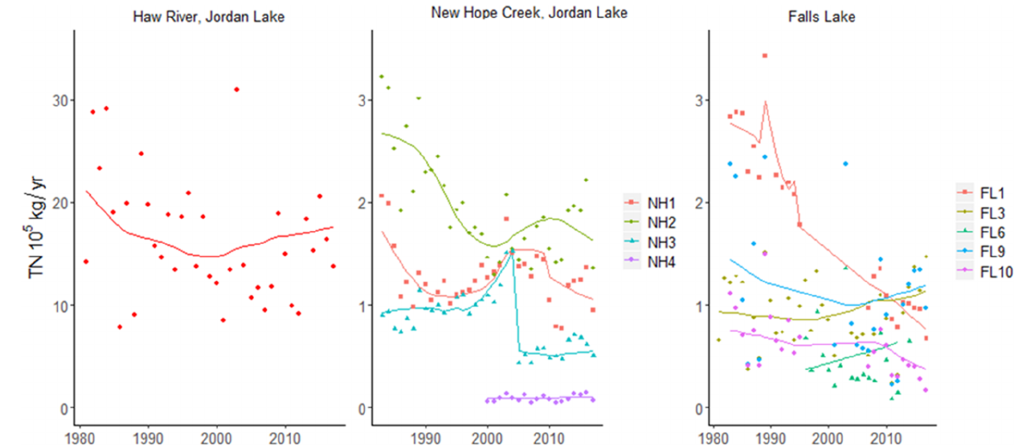
Figure 3. Weighted-regression on time, discharge, and season (WRTDS) annual nutrient loading estimates (points) and flow-normalized estimates (lines) for TN in the Haw River (HR) and New Hope Creek (NH) basins of Jordan Lake (JL) and Falls Lake (FL). For clarity, results are only shown for the most downstream load monitoring site (LMS) of each tributary to Jordan and Falls Lake. The only downstream LMS for Haw River is HR1. WRTDS loading estimates for other LMSs are provided in the Supplement (Fig. S4). Table 2. Posterior means and 95% credible intervals (CIs) of urban export coefficients (ECs) split by age and development density (low- density (LD) vs. high-density (HD) urbanization). The probability ( P ) that older urban lands (or HD urbanization) export more nitrogen than other urban lands was calculated by comparing Bayesian posterior draws. R 2 represents the ability of the model to predict temporal variability of loading at each LMS. Mean R 2 was determined by averaging the R 2 of all 25 LMSs. Case Export coefficient Mean 95% CI P Mean (EC) (TNha − 1 yr − 1